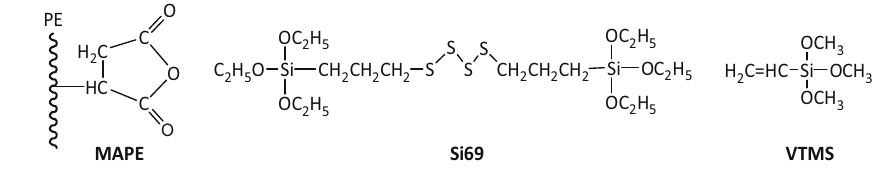
Figure 1: Chemical formulae of the coupling